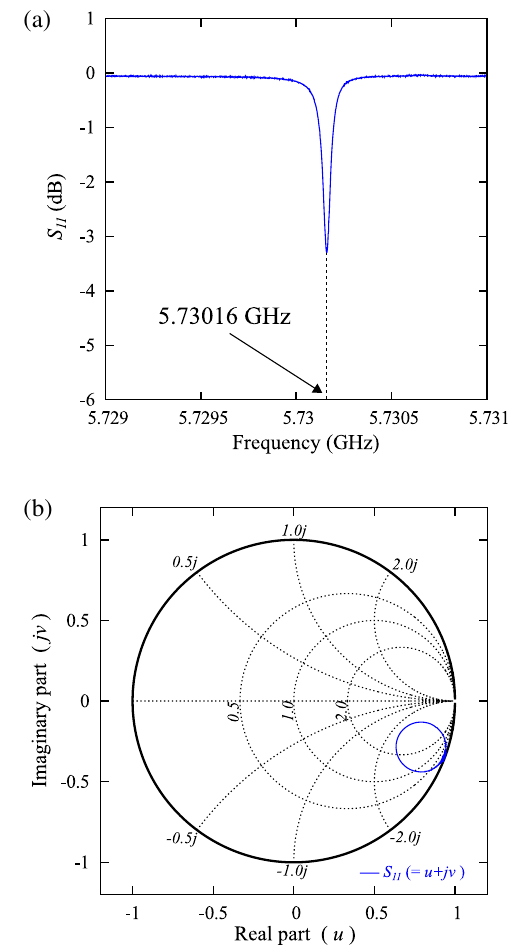
FIG. 7. Dependence of (a) the resonant frequency f 0 and (b) the unloaded Q factor Q 0 on the coupling coefficient β